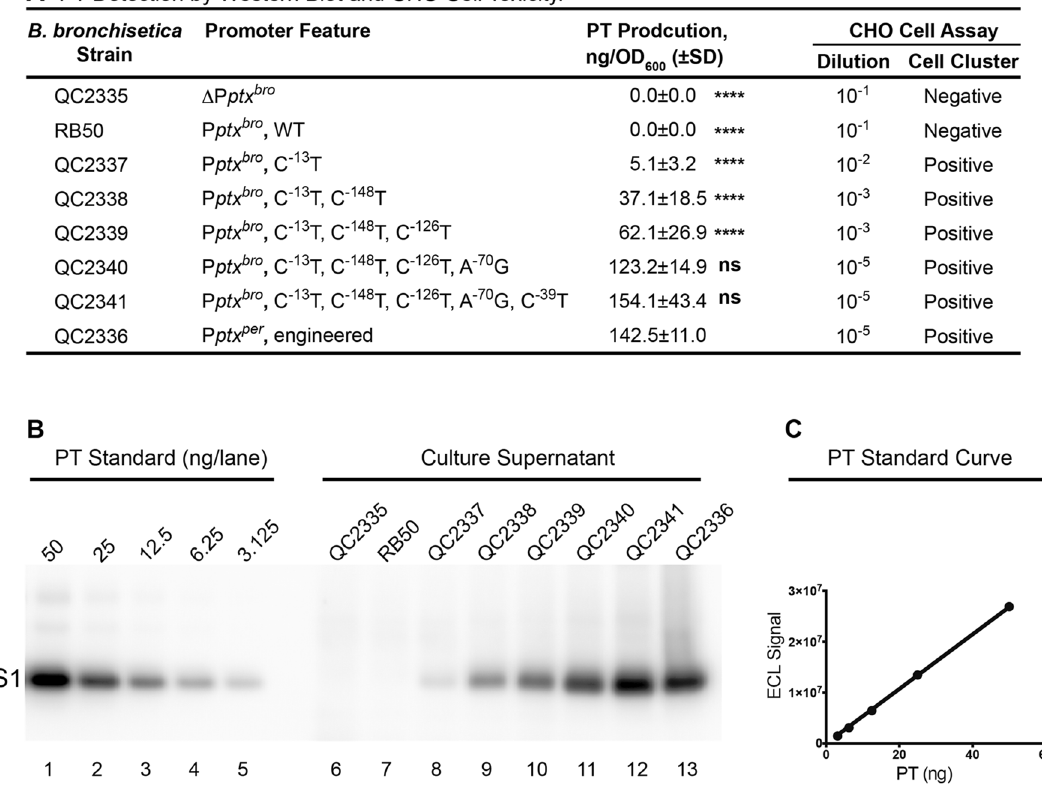
Figure 6. A small number of mutations in B. bronchiseptica RB50 P ptx can activate expression of functional PT . ( A ) Production of PT by wild-type and derivatives of B. bronchiseptica RB50 was determined by Western blot as described in ( B , C ) and shown in the third column. Values presented represent the mean and range from two independent cultures analyzed in this fashion. Statistical analysis of the results, using the values from QC2336 as a control group, is as in Fig. 1. Assessment of biological activity was performed by the CHO cell clustering assay as described in “Materials and methods” section and is presented in columns four and five. Supernatants analyzed by the CHO cell assay were the same ones assessed on the Western blot shown in ( B ) lanes 6–13. ( B ) Western blot probed with a monoclonal antibody against the pertussis toxin S1 subunit was performed following SDS PAGE analysis of known amounts of purified pertussis toxin containing all five subunits (lanes 1–5) or samples derived from culture supernatants (lanes 6–13). Culture supernatants and TCA-precipitated protein samples derived from them were obtained following growth of wild type B. bronchiseptica RB50, and derivatives containing mutations in the ptx promoter region, in LB plus streptomycin as described in “Materials and methods” section. ( C ) Densitometric analysis of lanes 1–5 provided data to produce a PT standard curve, shown here, which was then used to determine the mass per culture density (OD) of PT produced by different